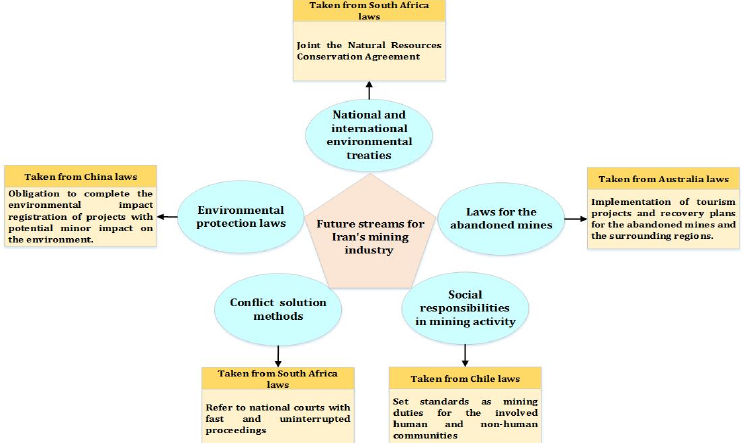
Fig. 3. A conceptual framework for improving Iran's mining